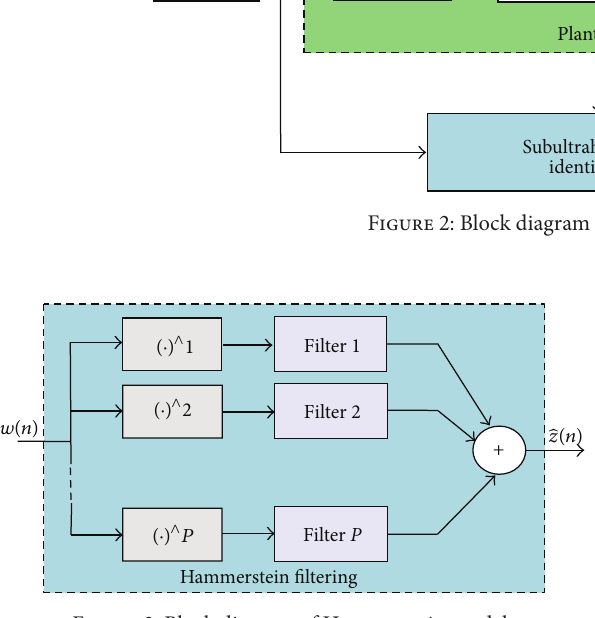
Figure 3: Block diagram of Hammerstein